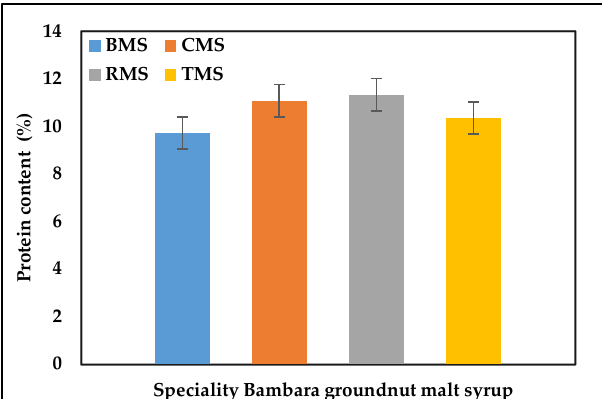
Figure 5. The protein content of the BGN speciality malt syrup, BMS—base malt syrup, CMS—caramel malt syrup, RMS—roasted malt syrup, TMS—toasted malt syrup.